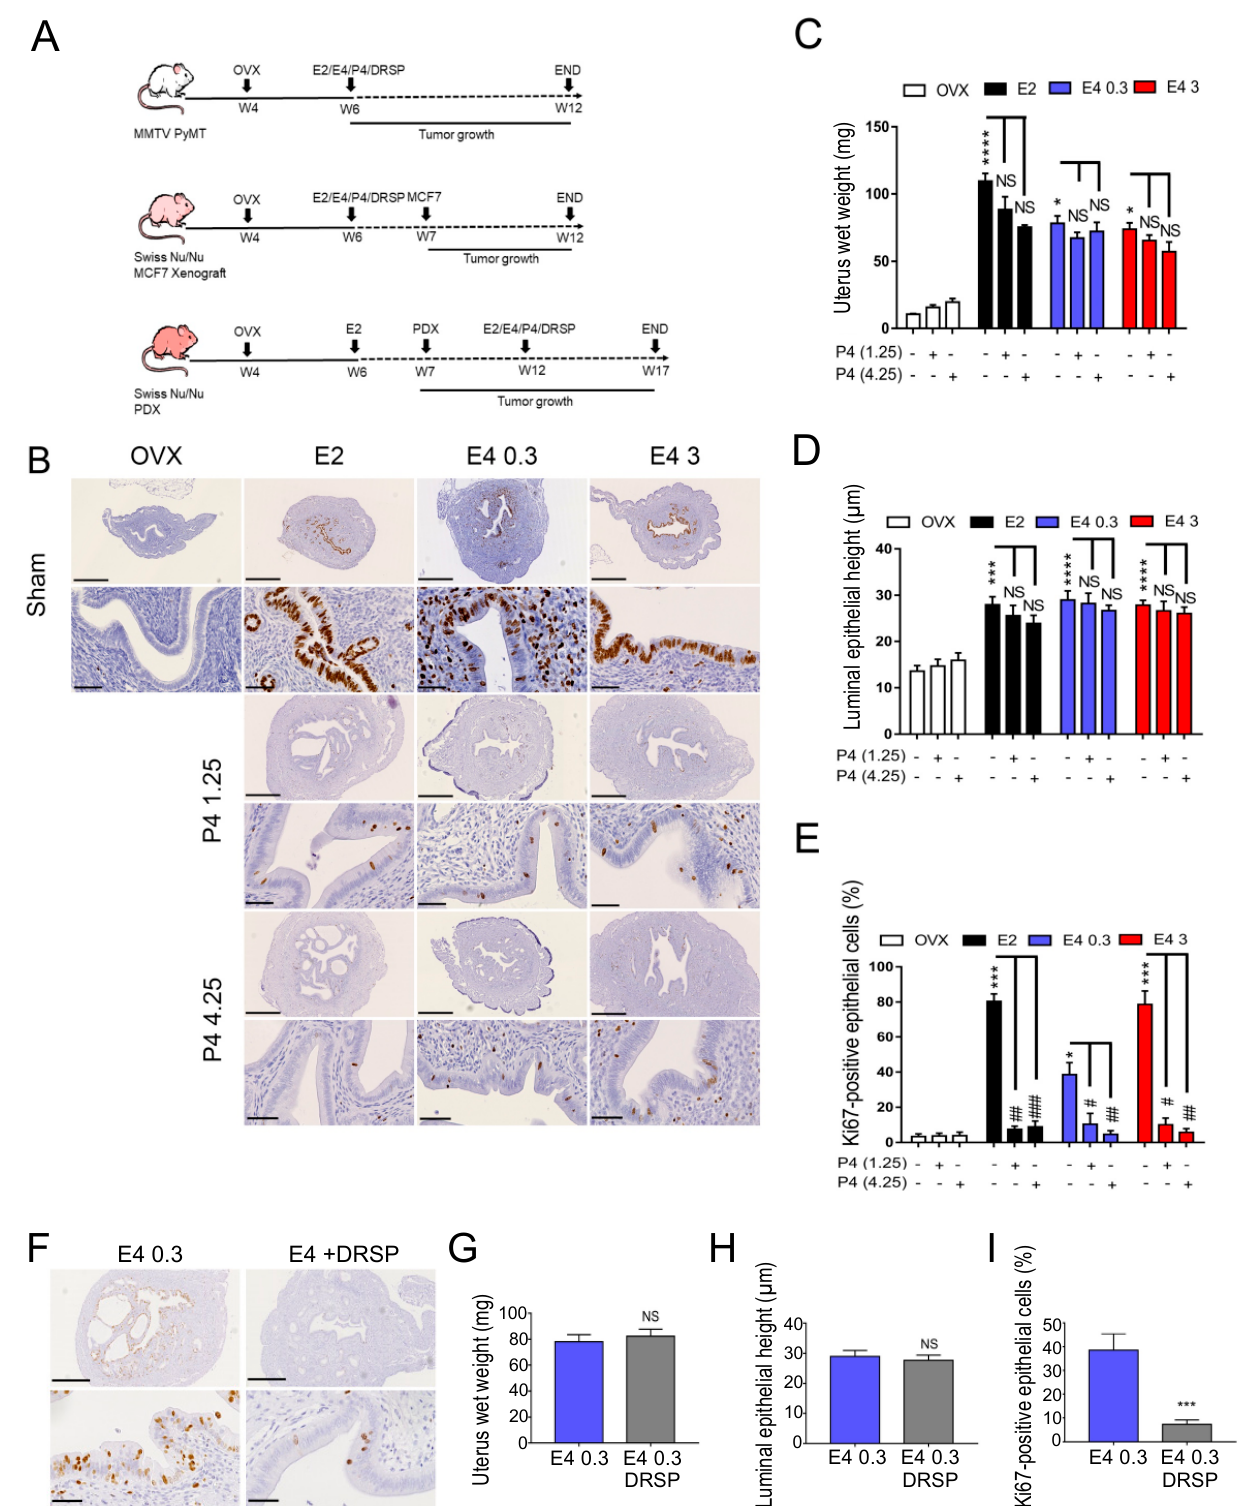
Figure 1. Uterotrophic effect of estetrol (E4), estradiol (E2), progesterone (P4) and drospirenone (DRSP). (A ) Treatment protocol schema of the three hormone-dependent breast cancer mouse models: MMTV-PyMT, MCF7 xenograft and patient-derived xenograft (PDX). OVX, ovariectomy; E2/E4/P4/DRSP treatment start pointed by arrows; MCF7, tumor cell injection; PDX, tumor graft; END, mouse sacrifice; W4-W17, 4–17 weeks of age. ( B ) Representative Ki67 immunostainings on uterus harvested from MMTV-PyMT mice untreated (OVX) or treated with E2, E4 (0.3 or 3 mg/kg/day) combined with or without P4 (1.25 or 4.25 mg/kg/day); scale bar = 500 µm, zoom scale bar = 50 µm. Quantification of ( C ) uterine wet weight, ( D ) luminal epithelial height and ( E ) epithelial cell proliferation (Ki67-positive staining). ( F ) Representative Ki67 immunostainings on uterus harvested from MMTV-PyMT mice treated with E4 (0.3 mg/kg/day) with or without DRSP (0.06 mg/kg/day); scale bar = 500 µm, zoom scale bar = 50 µm. Quantification of ( G ) uterine wet weight, ( H ) luminal epithelial height and ( I ) epithelial cell proliferation (Ki67-positive staining). Kruskal–Wallis analysis followed by Dunn’s post-tests or Mann–Whitney analysis, n = 6–8 mice/condition. NS: not statistically significant; * or #: p < 0.05; ** or ##: p <